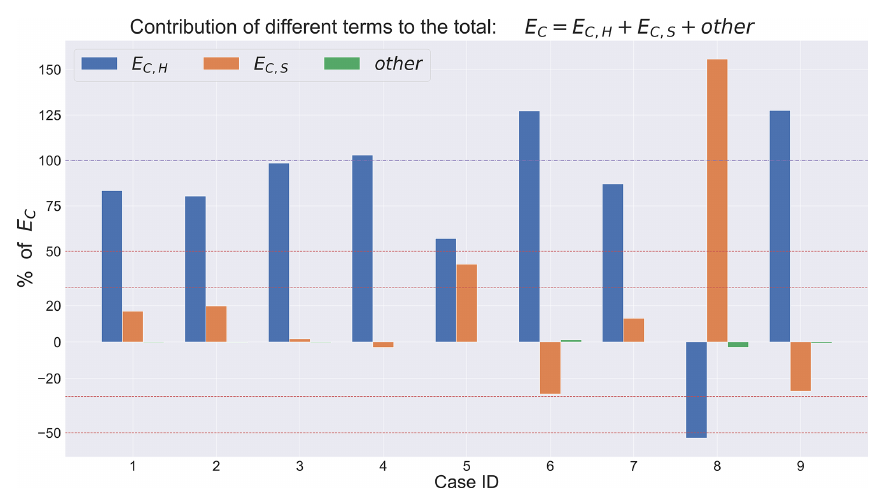
Figure 4. Contribution (%) of different terms in Eq. (7) to the total retrieved emissions ( E C ), for the nine JOSM 2013 cases. The 100% contribution level is marked with a (purple) dot-dashed line, ± 30% and 50% levels are also marked with (red) dashed lines on the figure. The main contributing terms were E C , H and E C , S ( > 97%). The other terms contributed < 3%